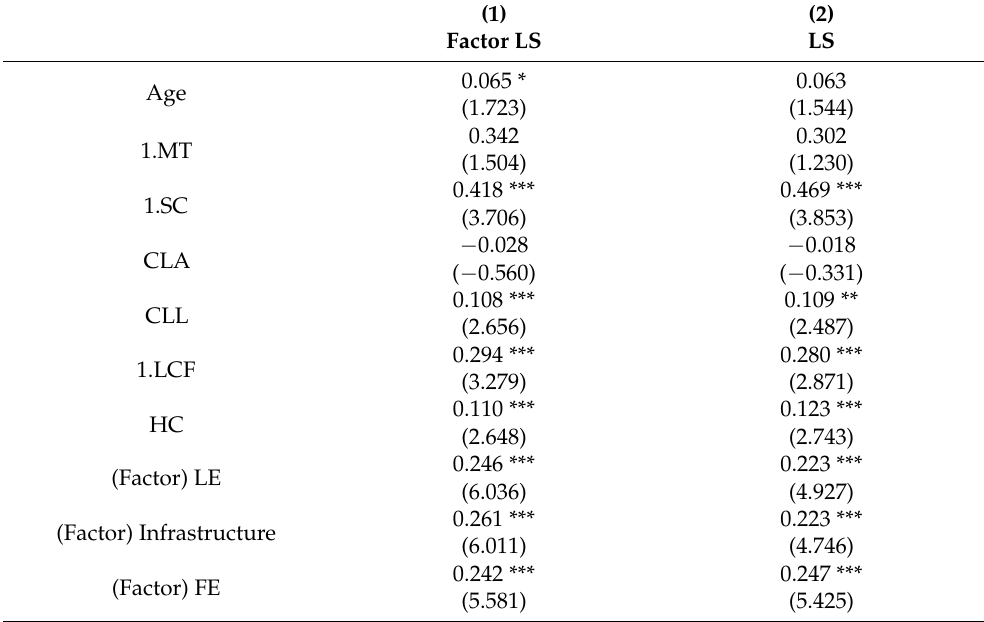
Table 6. Robustness